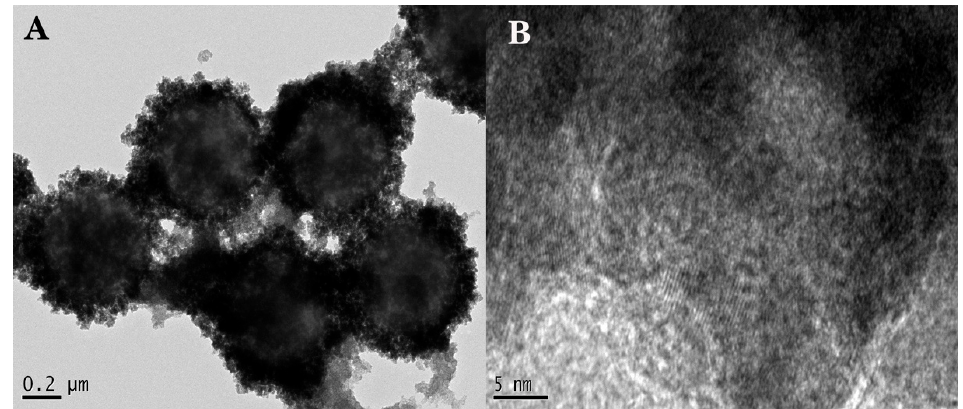
Figure 2. ( A )Transmission electron microscopy (TEM) images of the DMFN; ( B ) High-resolution TEM images of the DMFN.